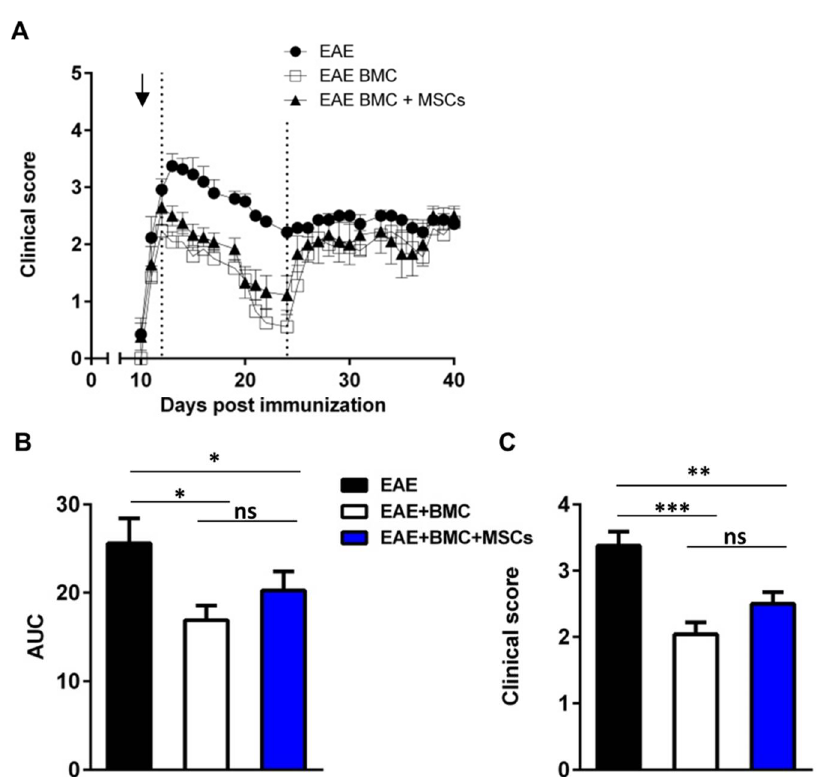
Figure 2. Co-transplantation of HSCs and MSCs has no synergistic beneficial effect on EAE course or severity. ( A ) EAE course of mice untreated, irradiated and treated with HSCs, or irradiated and co-transplanted with HSCs and MSCs (total mice tested per group n = 13). The arrow indicates the day when treatment was performed. Data are shown as mean ± SEM of daily clinical score. ( B ) Quantification of the area under the curve (AUC) corresponding to the first relapse (days 13 to 23 after disease induction, as delineated by the two doted lines on panel ( A ) during the course of the disease). Data are shown as mean ± SEM. * p < 0.05. ( C ) Comparison of the mean of clinical score between groups of mice untreated, irradiated and treated with HSCs, or irradiated and co-transplanted with HSCs and MSCs, at disease peak (day 14). ns refers to “not-statistically significant”. Data are shown as mean ± SEM. ** p < 0.01, *** p < 0.001 .